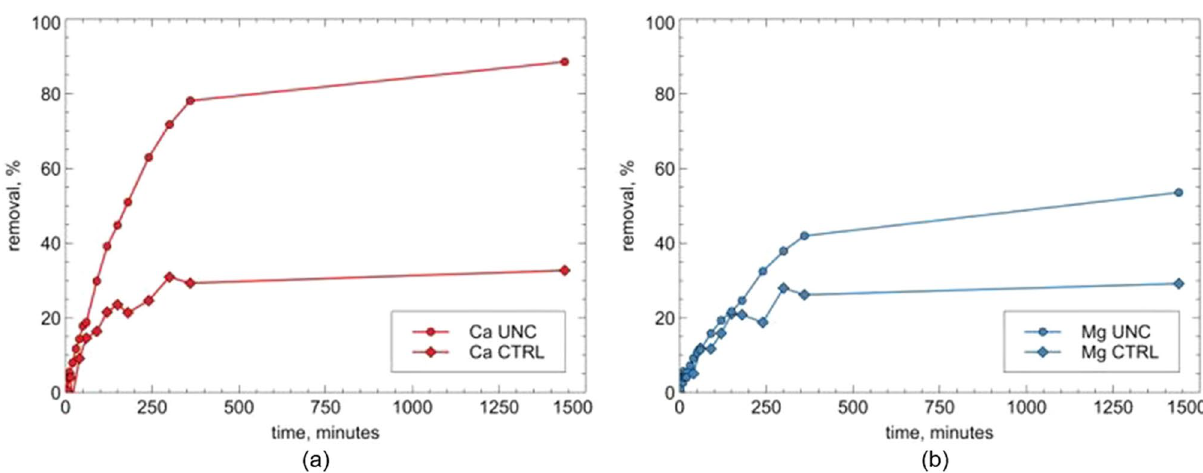
Figure 5. Calcium ( a ) and magnesium ( b ) kinetic curves for ZEOP samples under uncontrolled (UNC) and under controlled pH conditions, pH = 5, (CTRL).